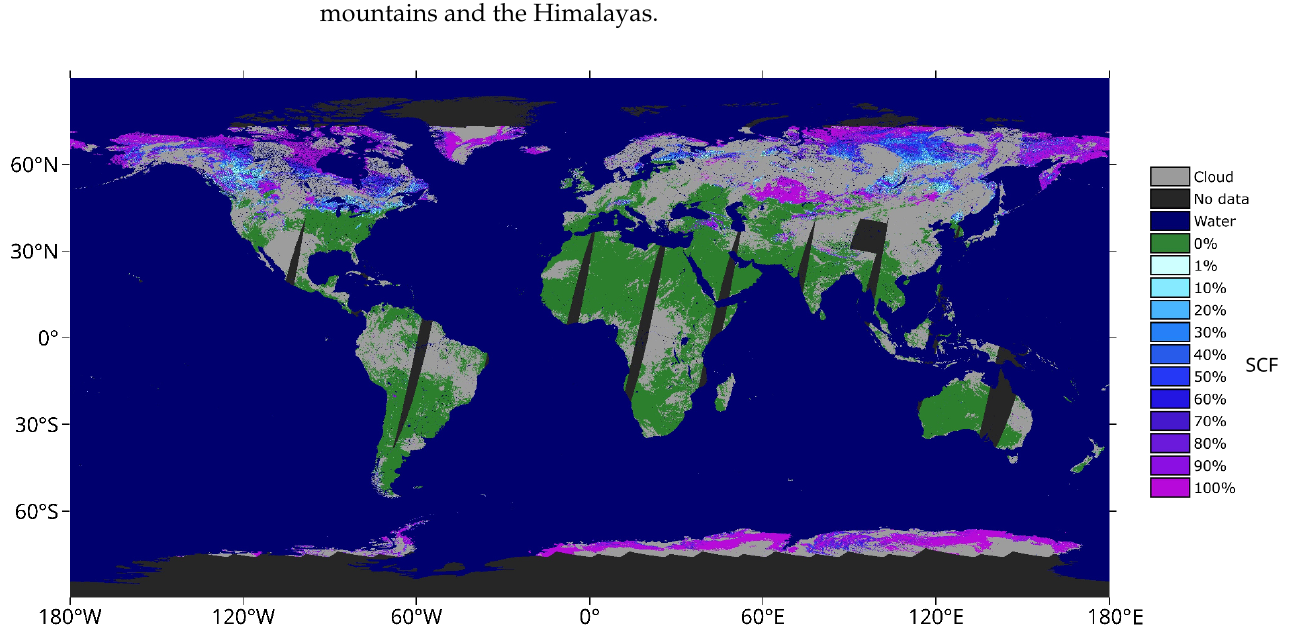
Figure 10. LAMSU SCF derived from Sentinel-3A/B SLSTR and OLCI data at 250 m resolution for